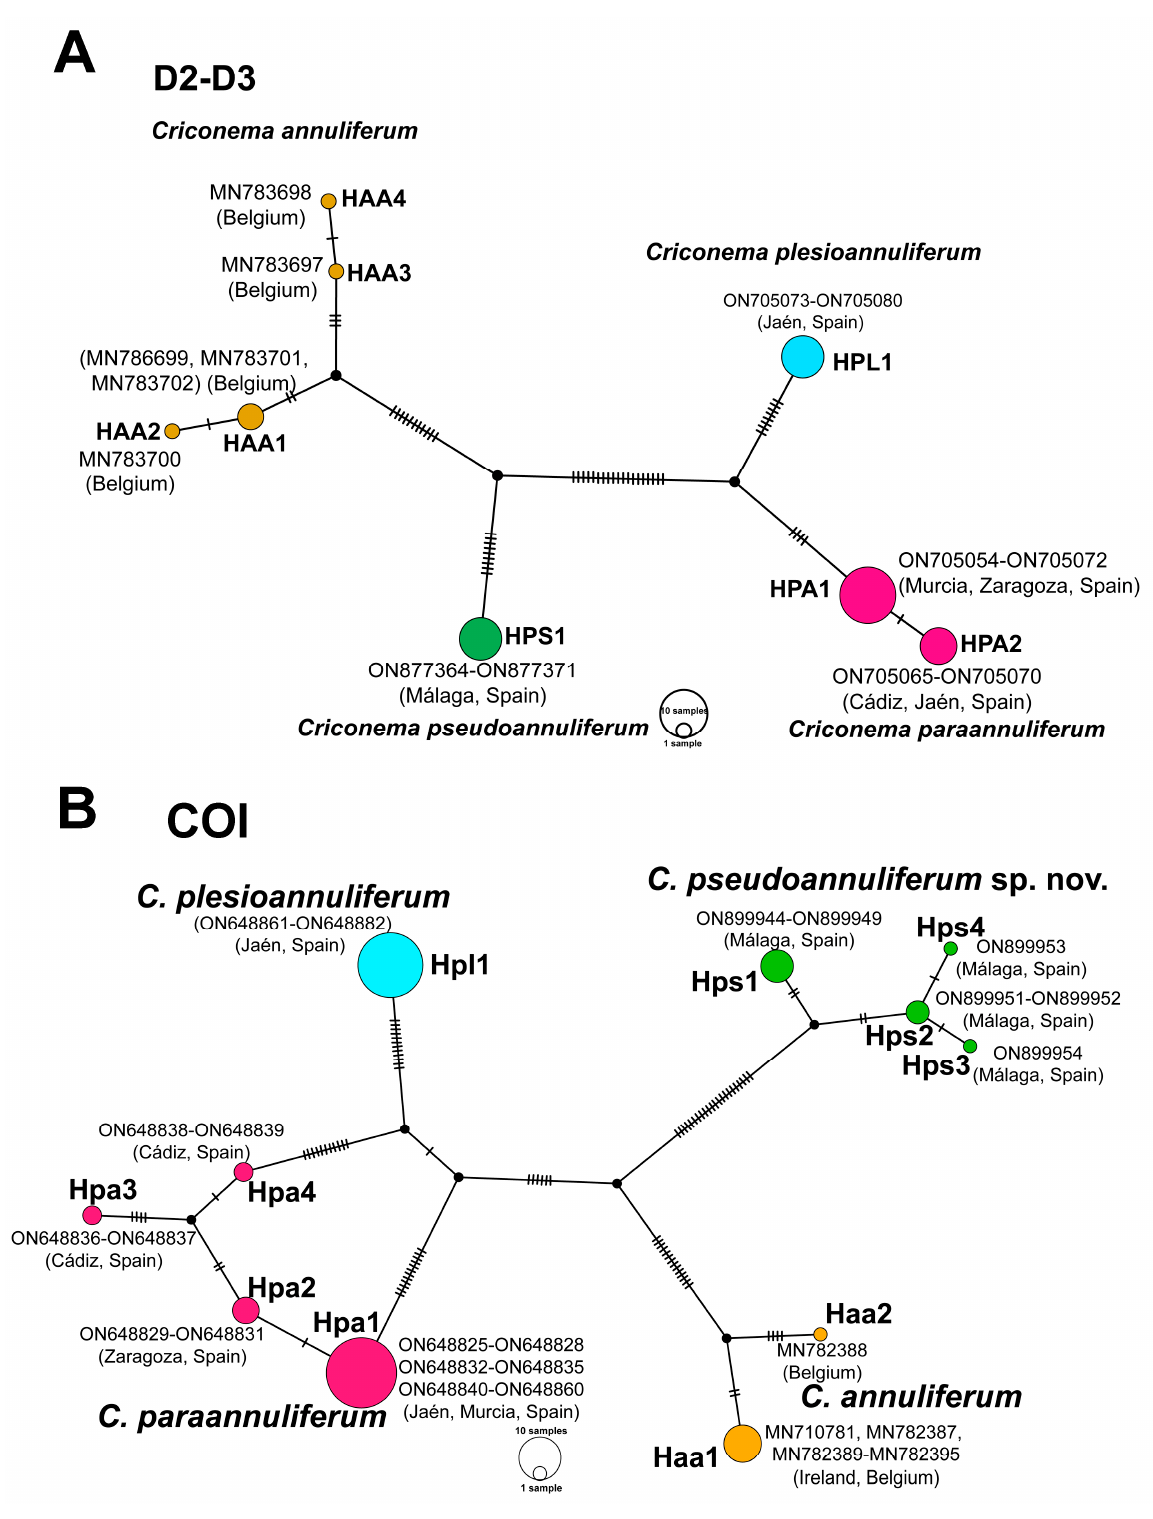
Figure 2. TCS network analysis of D2-D3 expansion segments of the 28S rRNA ( A ), and partial mitochondrial COI ( B ) haplotypes of Criconema annuliferum species complex. Coloured circles embody haplotypes and their diameter is proportionate to the number of individuals sharing the same haplotype. Black short lines on the branches specify the numbers of mutate nucleotide in the alignment that separate each haplotype. Small black circles represent missing haplotypes.